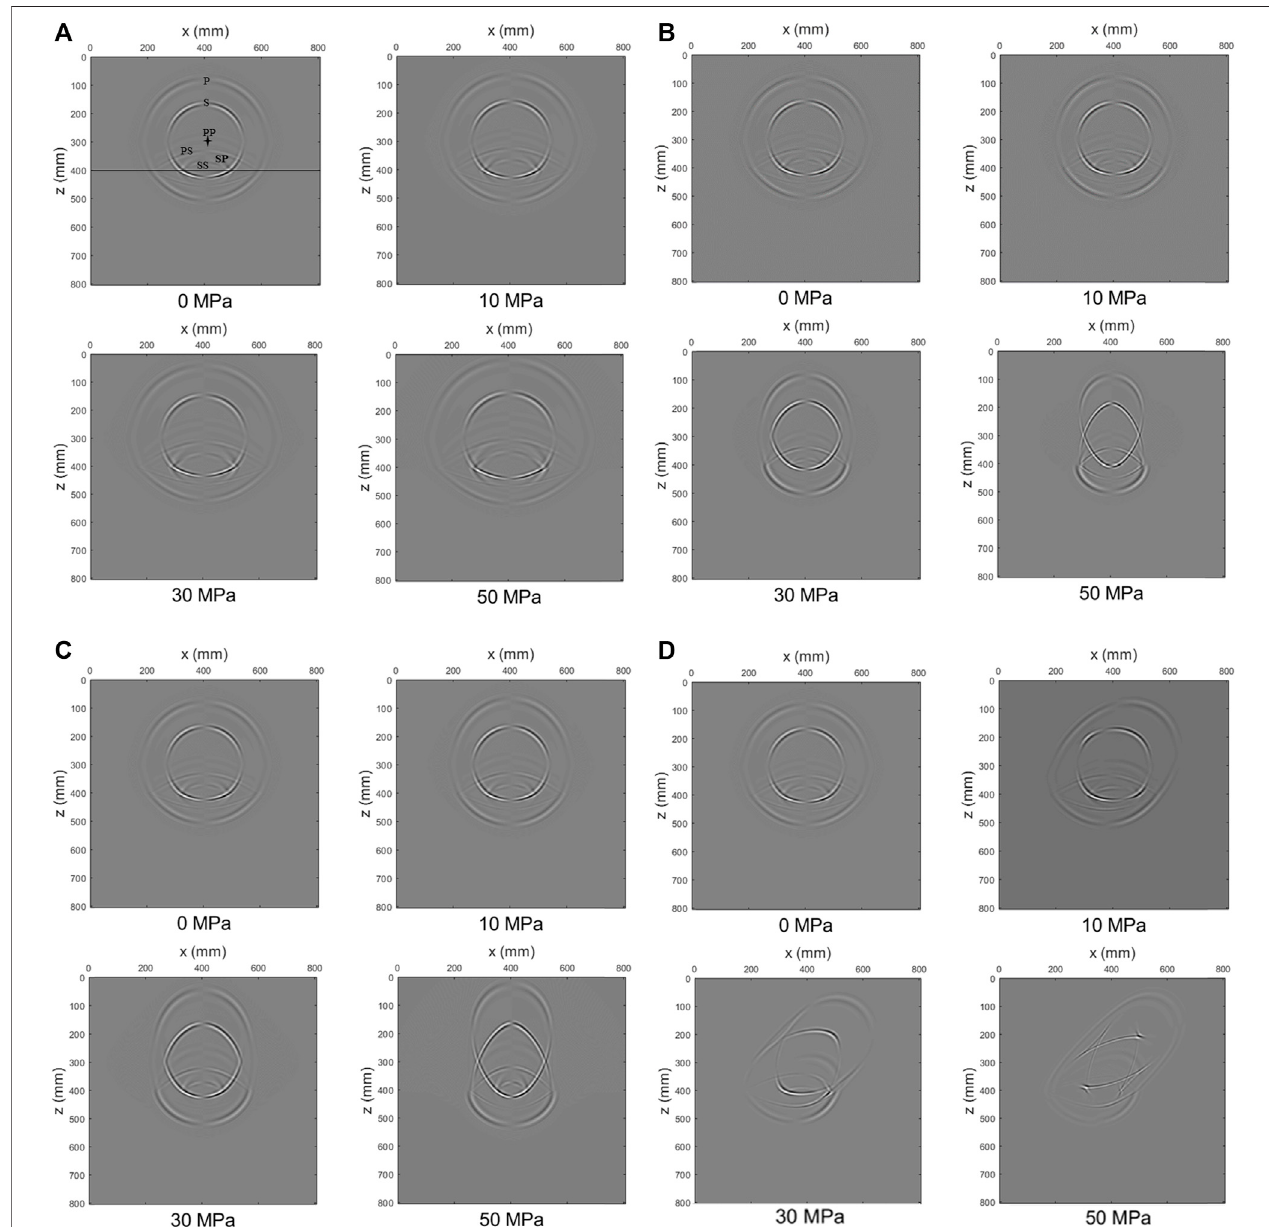
FIGURE 12 | Wave fi eld snapshots of the x -component of velocity at t = 0.08 ms for a double-layer model under various hydrostatic stresses (A) , uniaxial stresses (B) , pure-shear stresses (C) , and simple-shear stresses (D) . The location ofthe source is marked by a star in the fi gure. The consecutive wavefronts include P-wave (P), S-wave (S), P-wave re fl ection (PP), S-wave re fl ection (SS), P-wave converted S-wave (PS), and S-wave converted P-wave (SP) are observed.